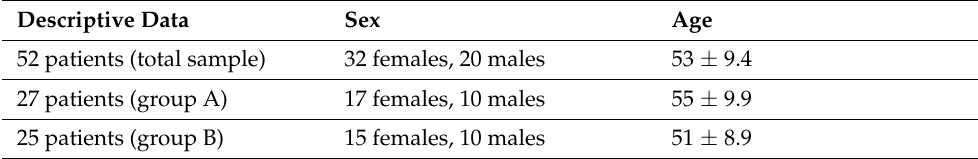
Table 1. Study population descriptive data. Descriptive